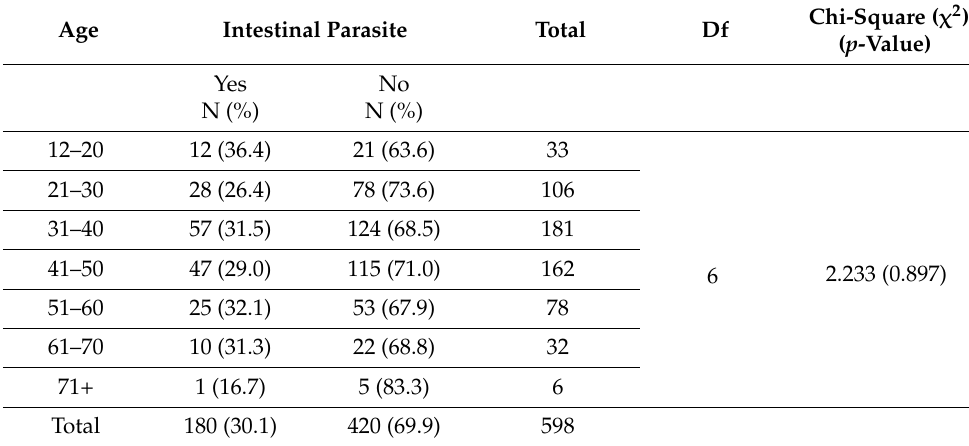
Table 4. Prevalence of intestinal parasites by age.